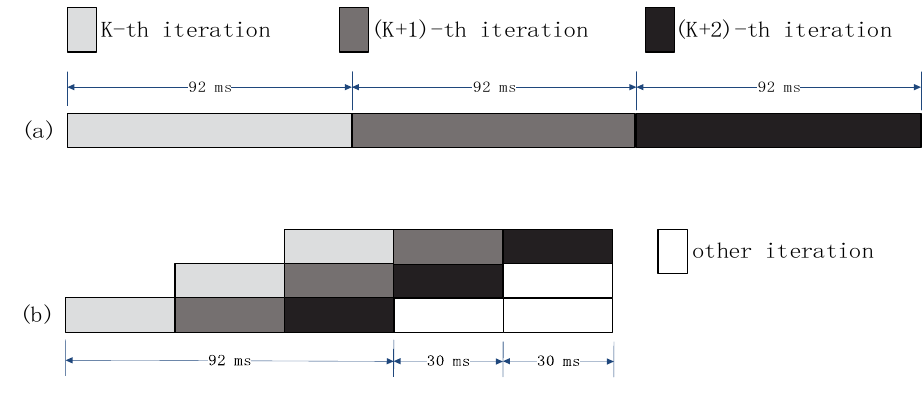
Figure 4. Schematic diagram of pipelining.